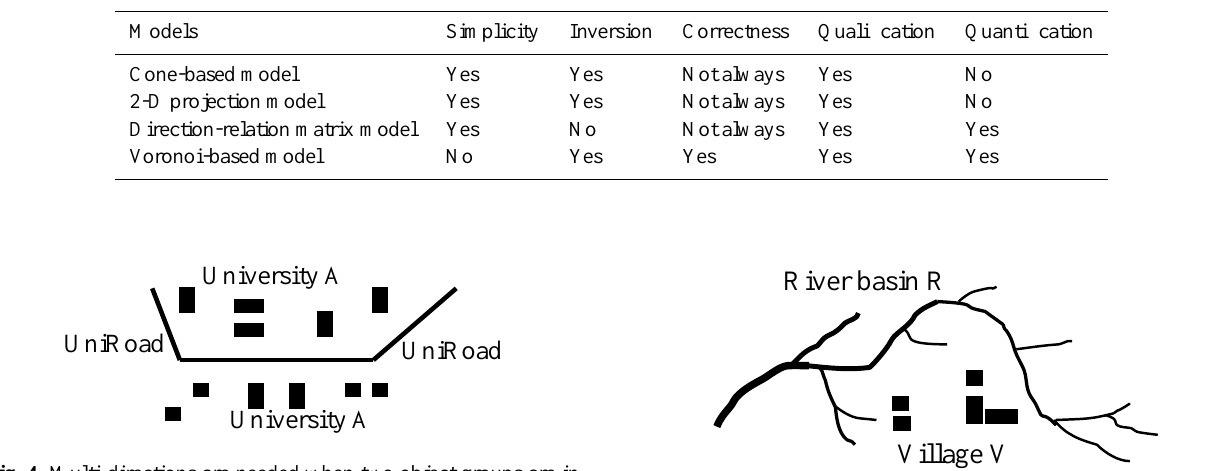
Table 1. Comparison of the existing models.